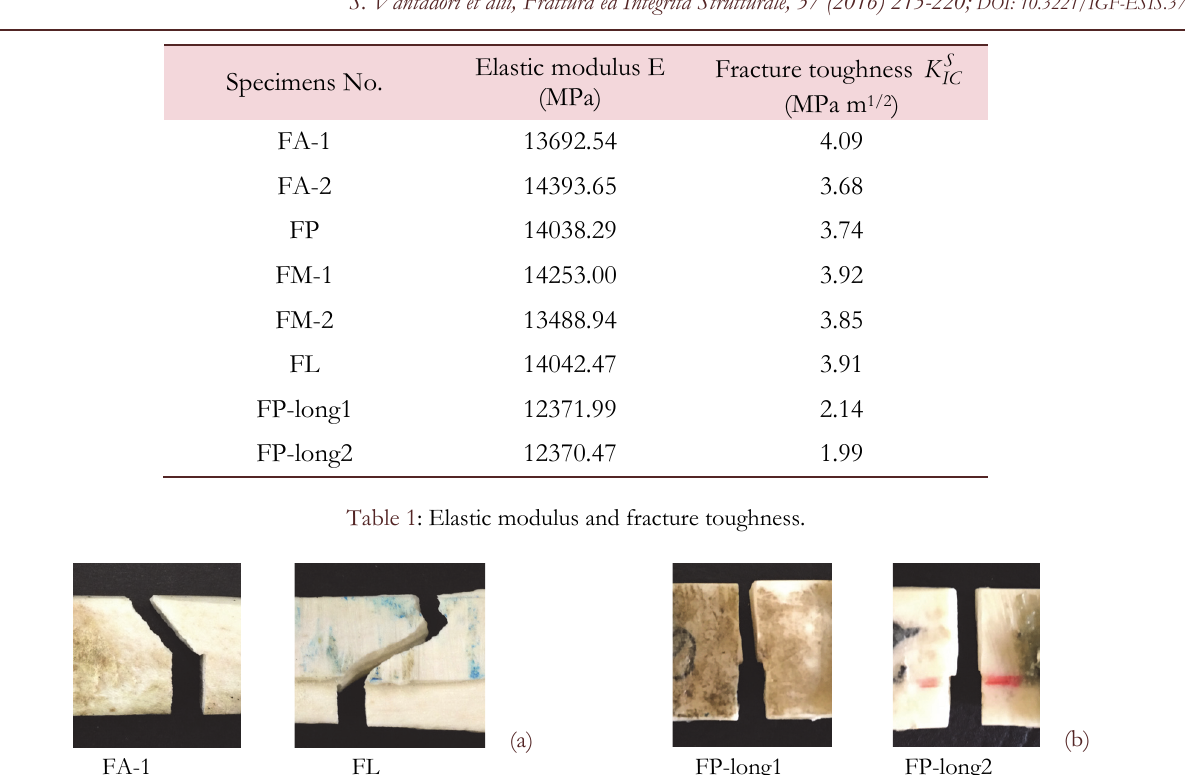
Figure 3: Fracture: (a) Mixed Mode for transversal specimens FA-1 and FL; (b) pure Mode I for longitudinal specimens.